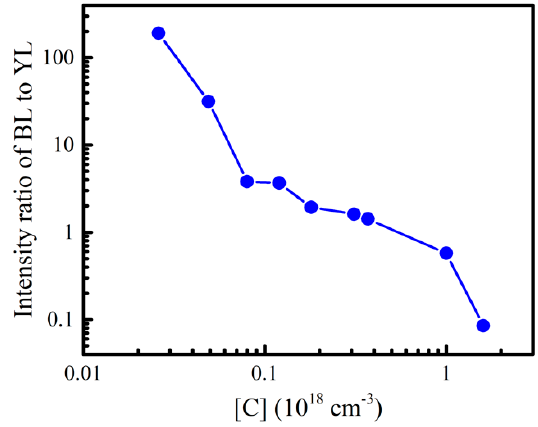
Figure 4. Dependences of the intensity ratio of BL to YL (circles) of u-GaN samples A0–I0 on the C concentration. The blue line in Figure 4 is used to guide the eye.